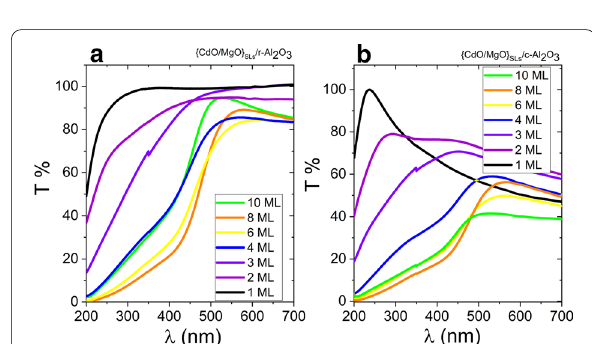
Fig. 3 Transmittance of {CdO/MgO} SLs films on ( a ) r -sapphire and ( b ) c